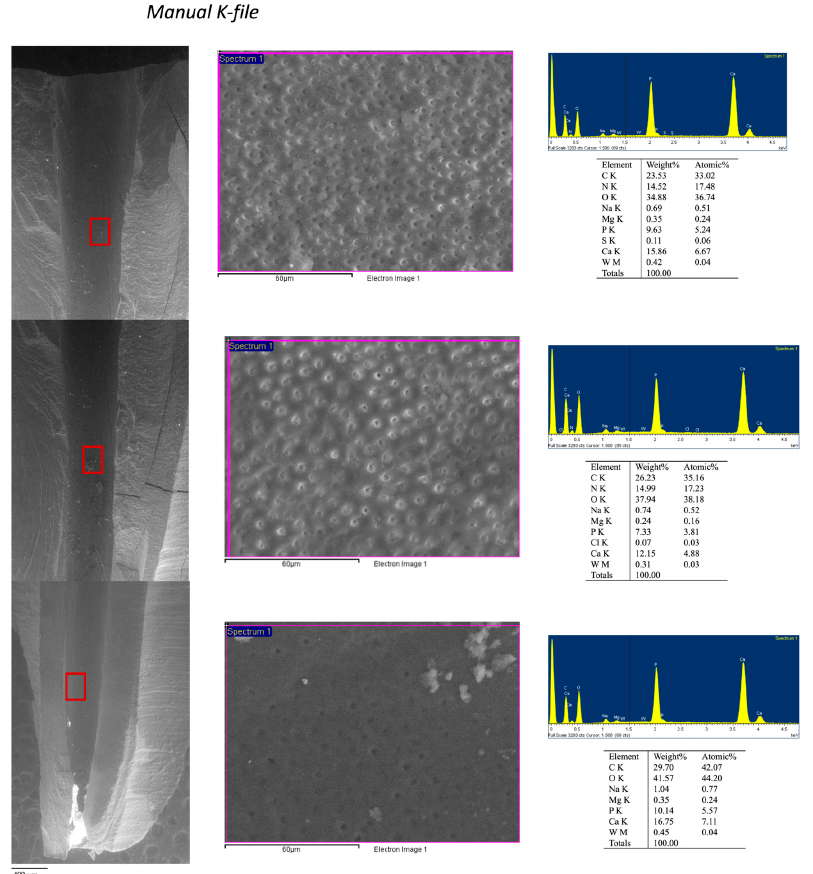
Figure 6. ESEM-EDX analysis at 100 × magnifications performed at the coronal medium and apical third of root retreated using a manual instrumentation technique. Both coronal and medium third revealed few filling debris. Di ff erently, apical third presented a higher presence of filling debris (evidenced as highly electron-dense deposits). EDX at 3000 × on dentin areas free from filling deposits showed a limited presence of W, attributable to the